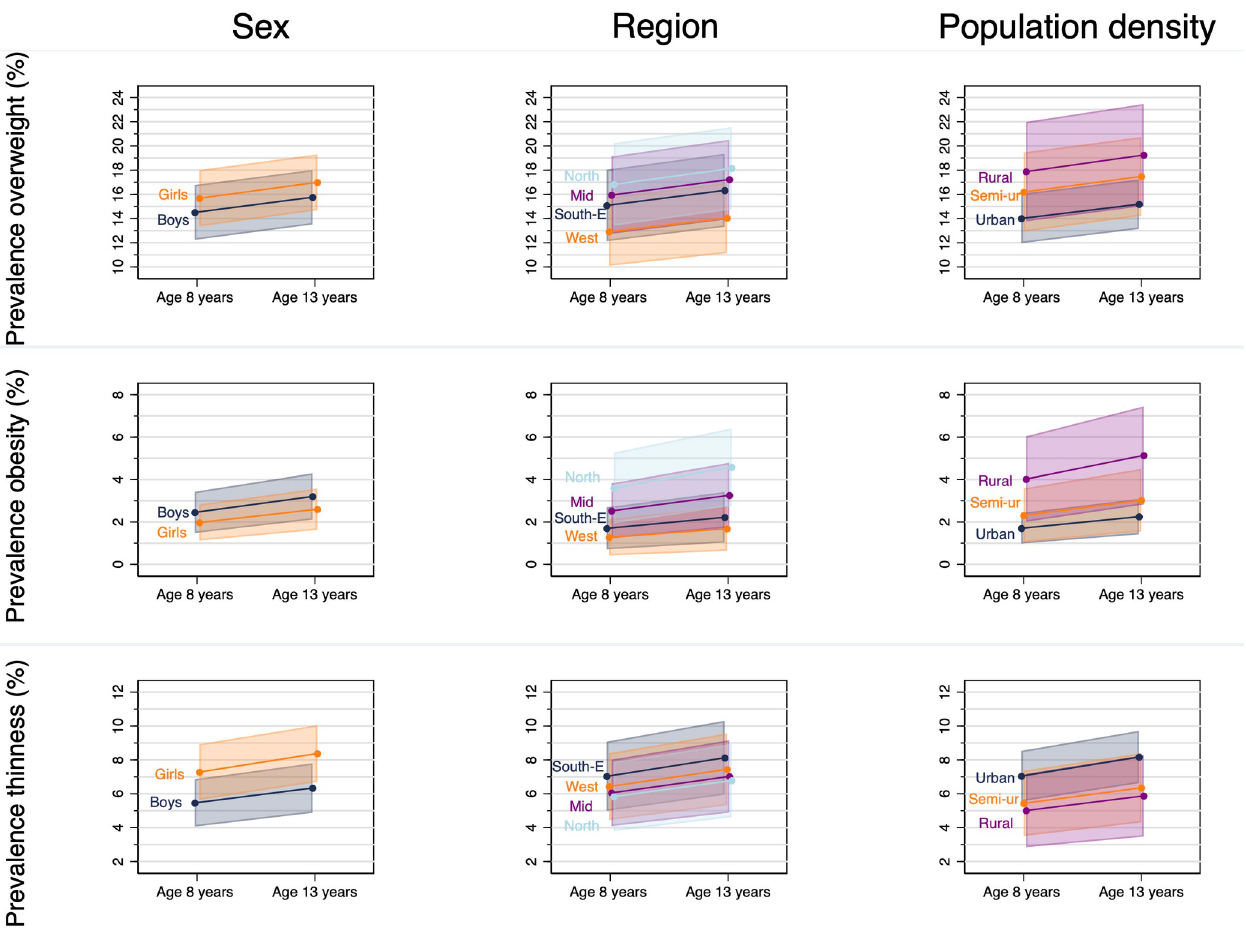
Fig 2. Predicted prevalence � of IOTF † overweight (top row), obesity (middle) and thinness (bottom) at 8 and 13 years, by sex (left), region (middle) and population density (right). IOTF, International Obesity Task Force. � Marginal estimates predicted as estimated from the random effect logistic regression models without an age interaction term, n = 1852, 3317 observations. The dots are the point estimates and the shaded area is the 95% confidence interval. The points have been staggered and joined between ages for clarity. † Categories are inclusive; overweight includes obesity and severe obesity, and similarly for categories of